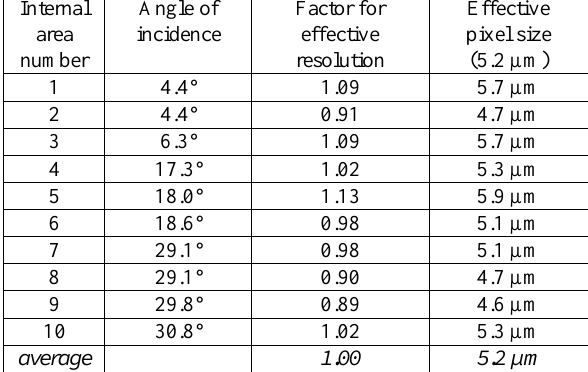
Table 6: Effective GSD of SkySat Basic Panchromatic images